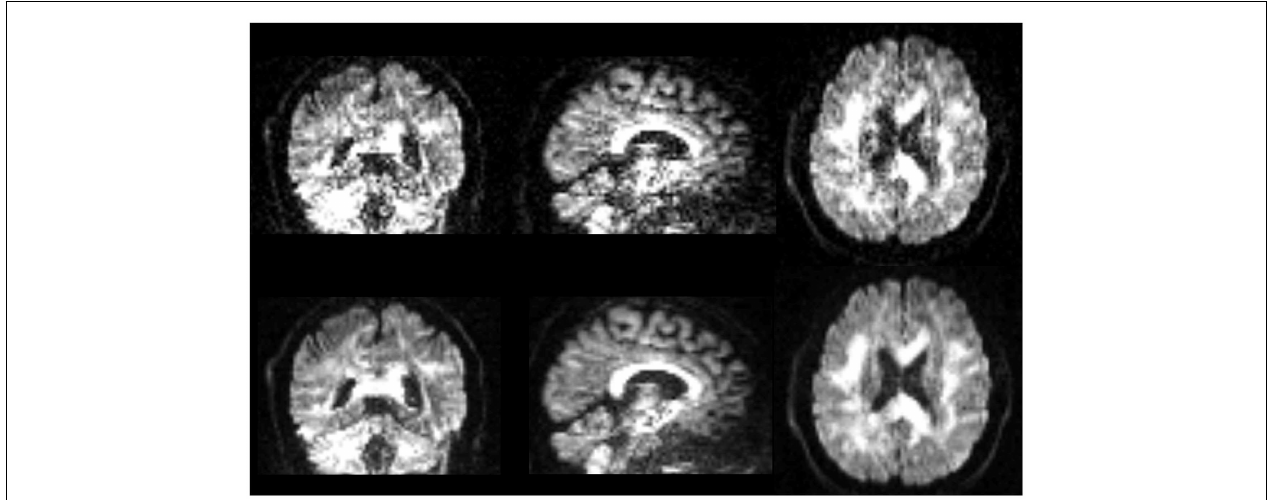
FIGURE 8 | Images are instances of human brain DWI from a given gradient direction, from raw-DWI (first row) and lop-DWI (second row) . Raw-DWI was corrected for motion, eddy current, and EPI distortion (see Method).